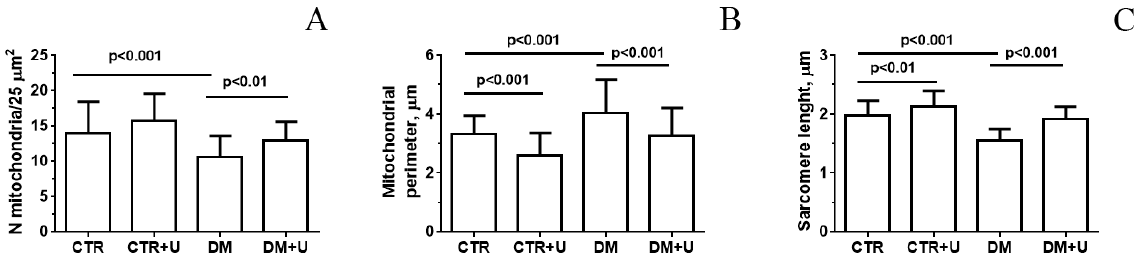
Figure 3. Ultrastructural analysis of the morphology of mouse cardiomyocytes in the experimental groups: the number of intrafibrillar mitochondria per field of view (25 μ m 2 ) ( A ), the perimeter of intrafibrillar mitochondria ( B ), and sarcomere length ( C ). The number of examined fields of view was 50–70 in each group. The values are given as means ± SD.